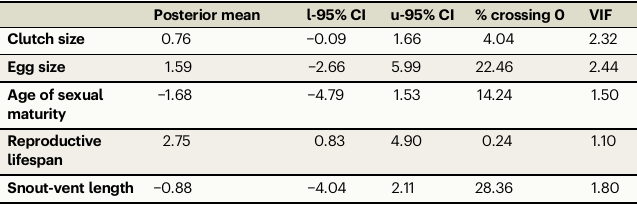
Full parametersformodel predicting introduction statuswithin amphibianstraded live by theUS, including allpredictors as none had VIFs>5 ( N =75, H 2 =0.30[0.00,0.76]).